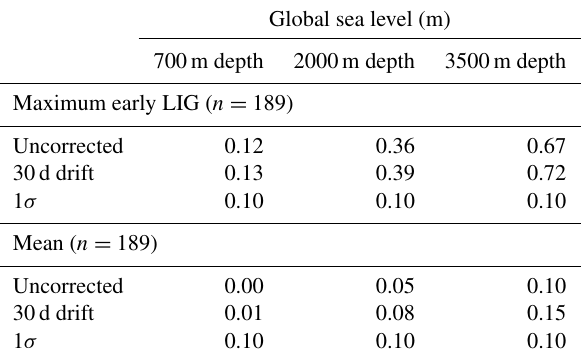
Table 2. Annual temperature-derived thermosteric contributions to global sea level during the Last Interglacial for ocean warming down to different water